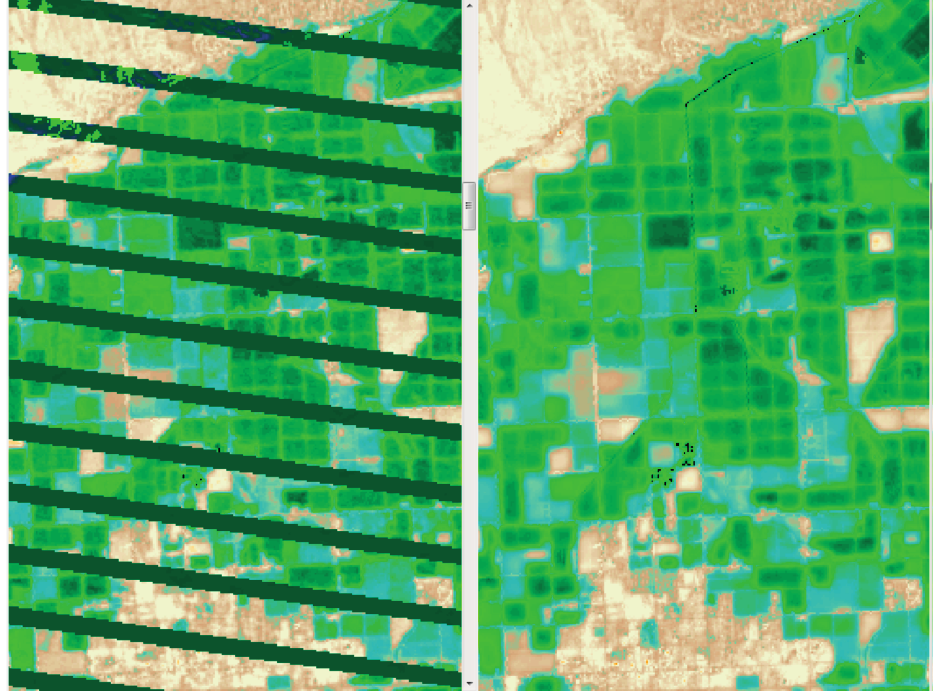
Figure 11. Landsat 7 evapotranspiration product ( left ) compared with that derived from Landsat 8 ( right ). Dark greens indicate higher ET and blues and beiges progressively lower ET. The two maps are quite consistent with each other. Landsat 7 data are sharper, because the Landsat 7 thermal sensor has 60-meter resolution compared to TIRS’s 100-m resolution. Data gaps in the Landsat 7 product are due to the scan-line corrector